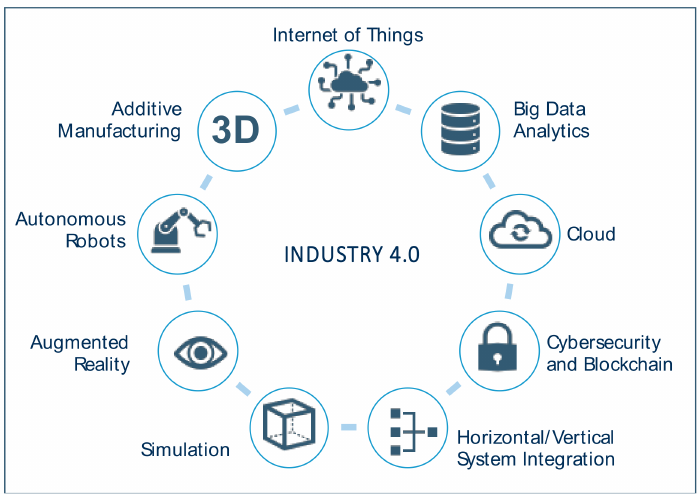
Figure 2. The nine Digital Technologies supporting Industry 4.0. Adapted from